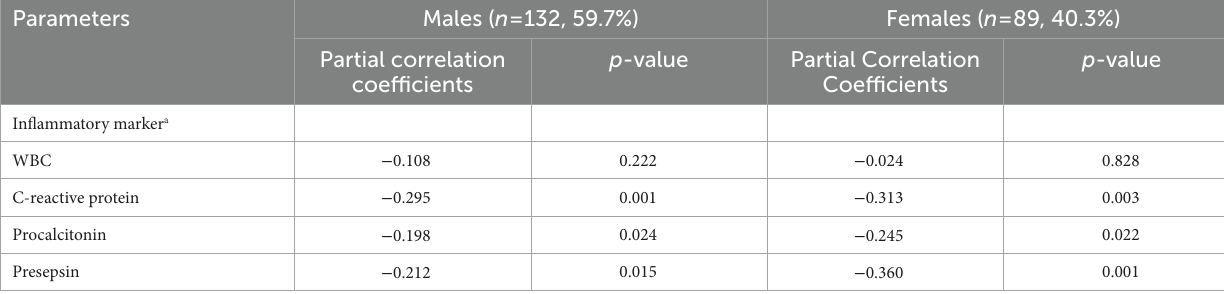
TABLE 2 Partial correlation between PhA measured at 50 kHz on BIA and various parameters after adjustment for age and BMI. Parameters